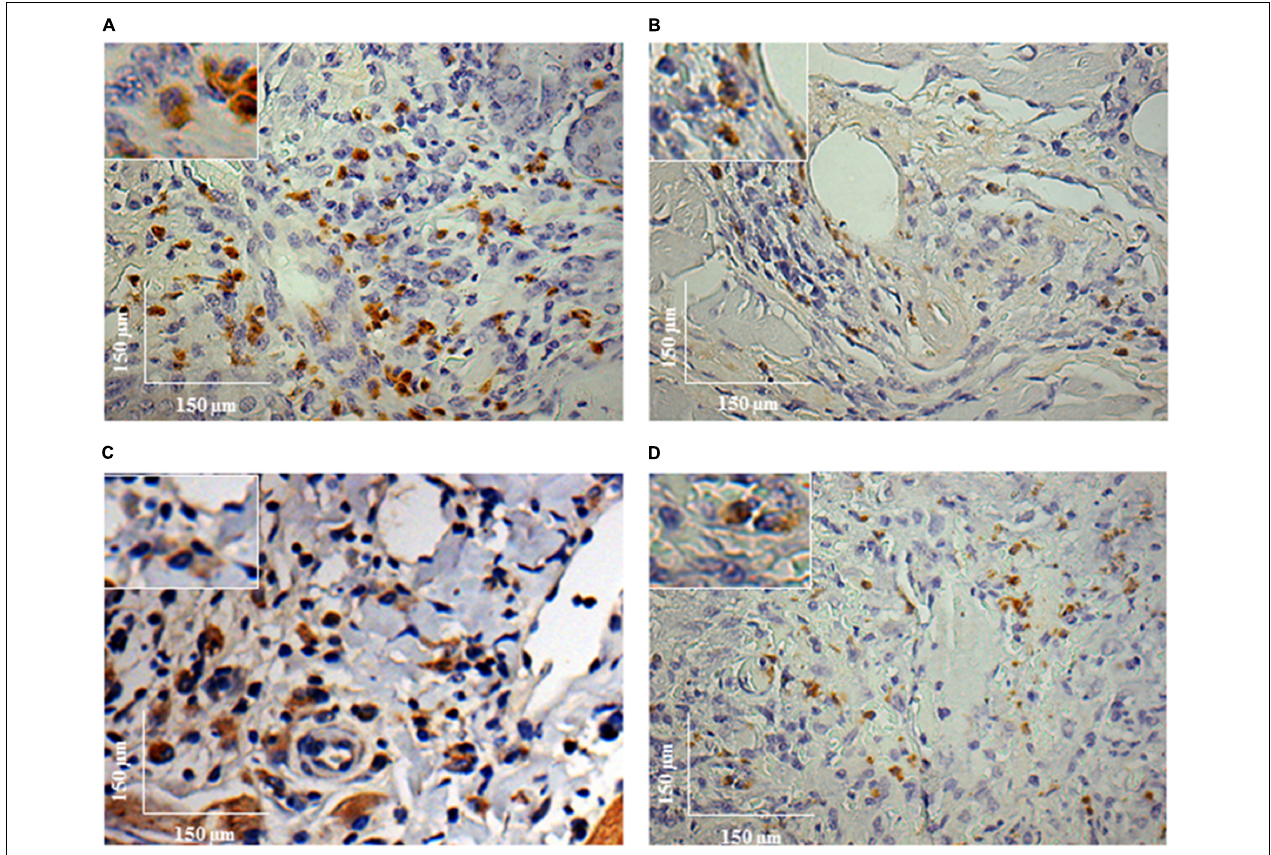
FIGURE 6 | Immunohistochemistry (IHC) using anti-L1 mAb of C. porcellus infected with L. enriettii (L88 and Cobaia) strains in the absence/presence of salivary gland extract (SGE). L88-infected animals exhibited an intense L1 positive cells staining at 8 weeks PI in the absence (A) and presence (B) of SGE. In the absence of SGE, Cobaia-infected animals exhibited a higher L1 positive cells staining (C) than in the presence of SGE (D) at 12 weeks PI. Amplified areas in the upper left side showing macrophage